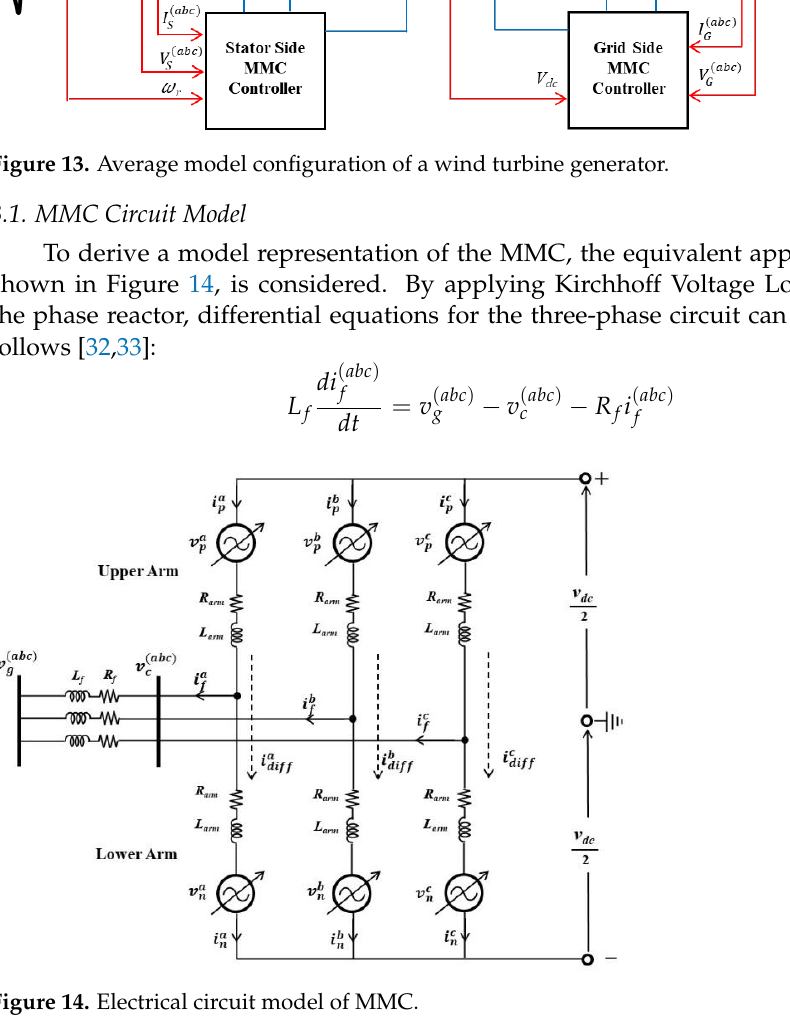
Figure 14. Electrical circuit model of MMC.